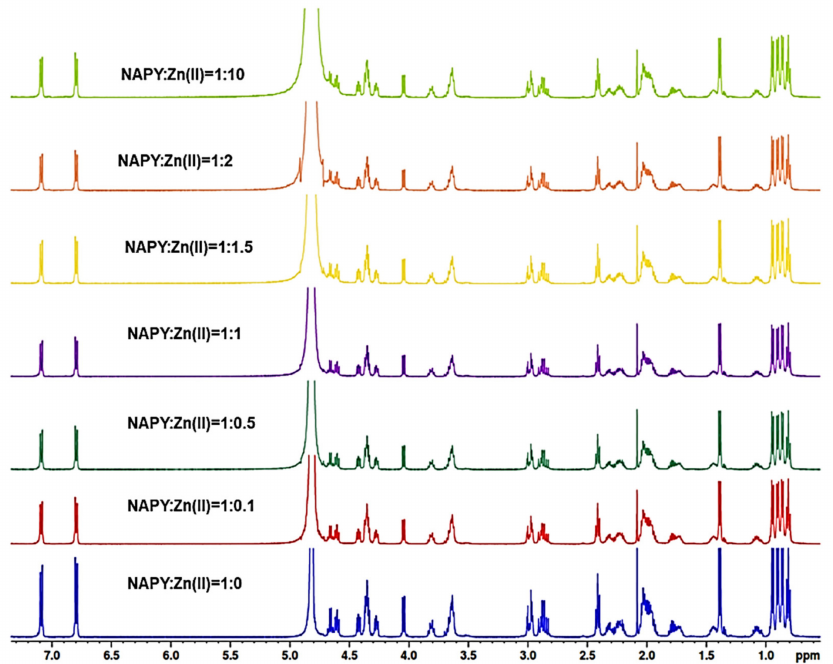
Figure 7. 1 H-NMR spectrum in the aliphatic region of NAPY peptide titrated with increasing amounts of Zn 2+ at pH = 5.